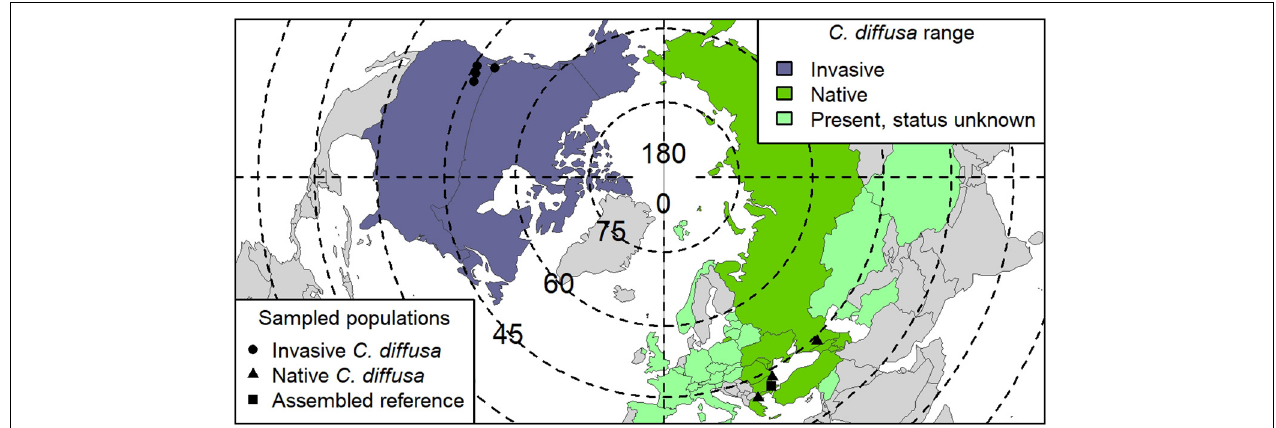
FIGURE 1 | Centaurea diffusa range map. Global range of C. diffusa , by country (modified from Turner et al., 2014). Range status in a particular country is indicated by color. “Present, status unknown” also includes countries where C. diffusa is considered naturalized. Points indicate seed collection locations used in GWAS study. One native population (TR001, Turkey; Supplementary Table S1 ) was used for both the reference assembly and as a population in GWAS. Degrees of latitude are indicated on dotted lines, and degrees of longitude, solid lines.